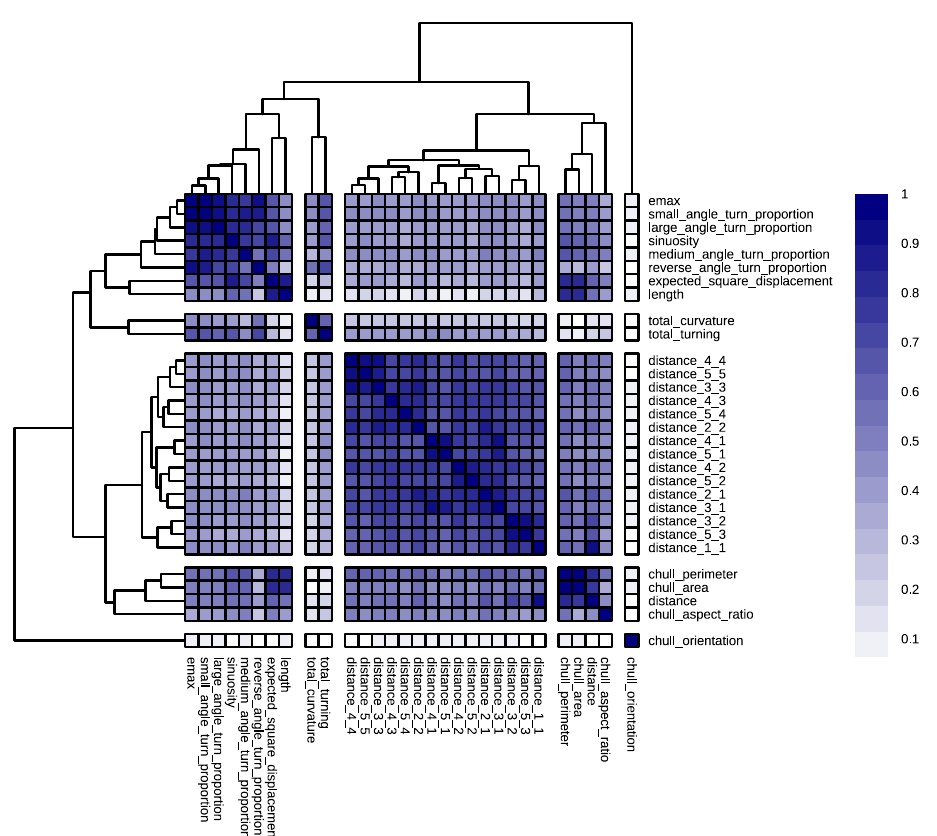
Figure 6. The hierarchical clustering of the similarity matrix that consisted of the geometric descrip- tors. The similarity index for a pair of descriptors is between 0 and